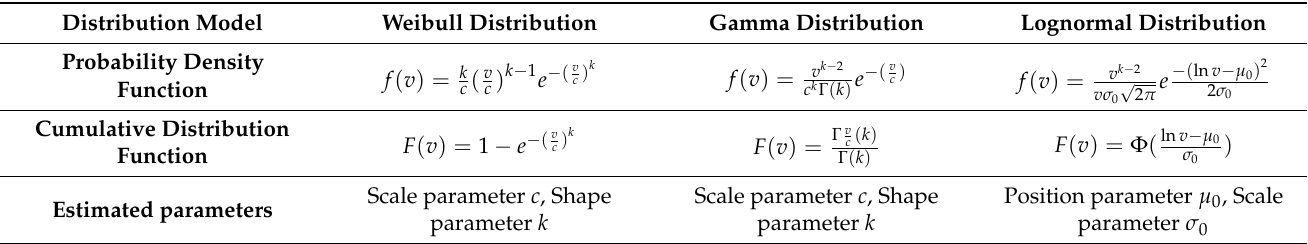
Table 2. Common wind speed probability distribution